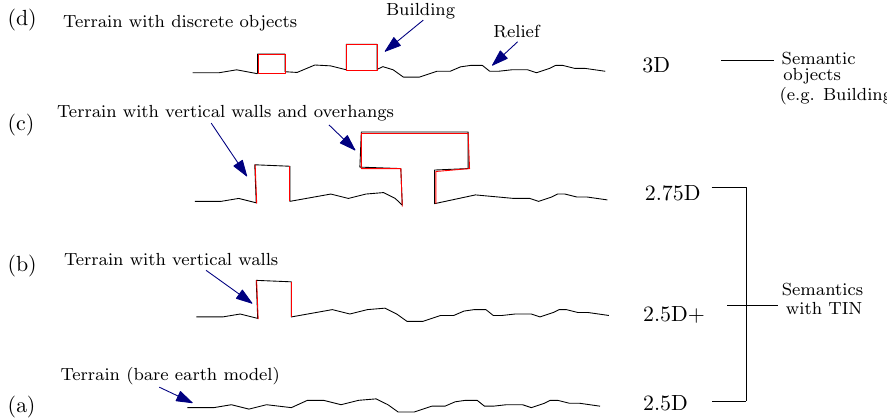
Figure 2. Terrain represented as a constrained TIN with building footprints integrated in it.